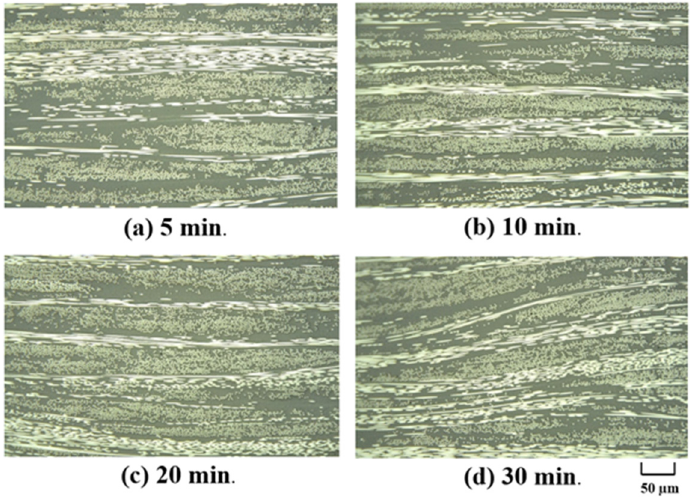
Figure 13. Cross-sectional photographs of composite materials made at different molding times un-